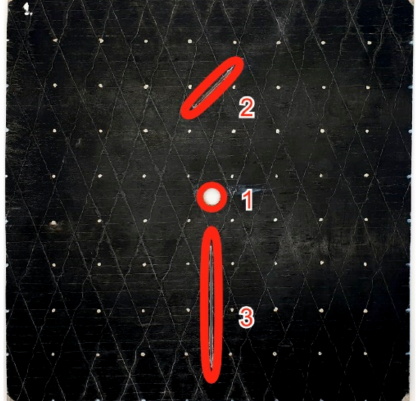
Figure 10. The GFRP/MWCNT composite plate with defects: hole (case 1) and notches (cases 2 and 3). Numbers show the sequence of the created